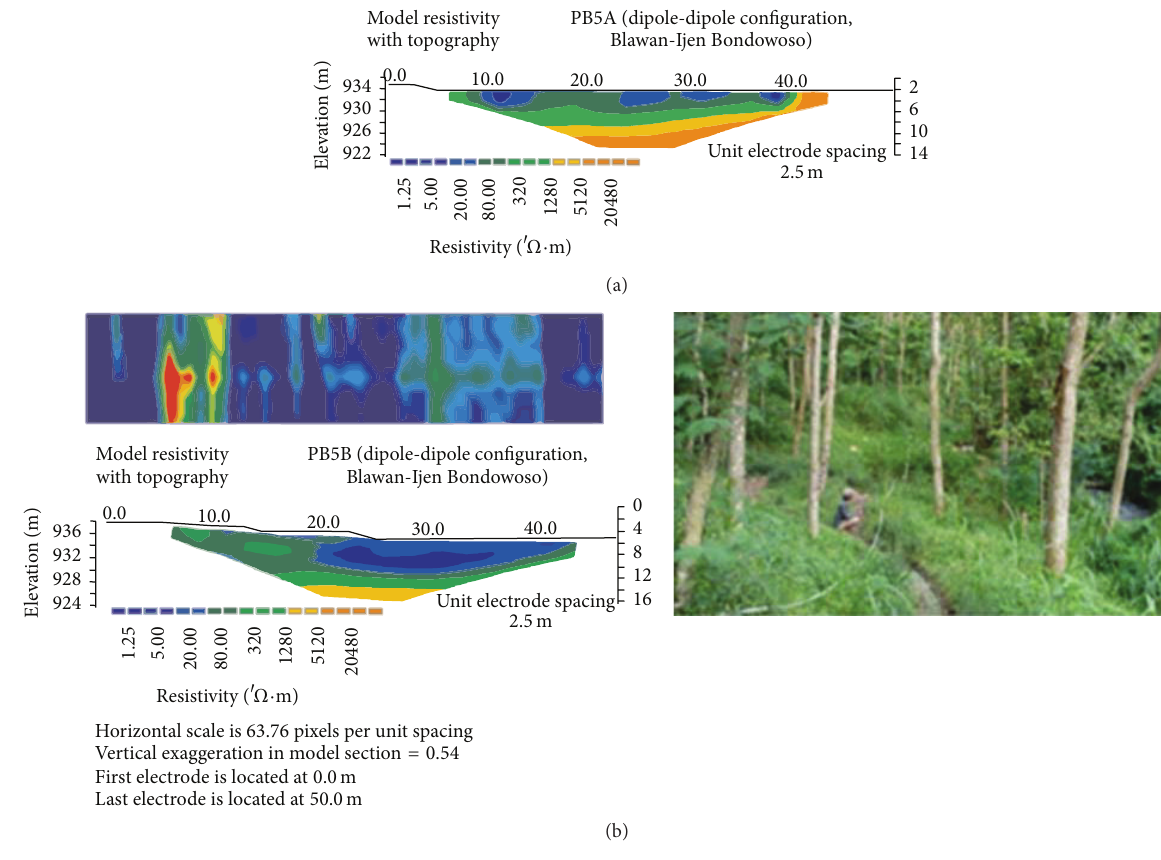
Figure 9: 2D Resistivity Mapping and GPR amplitude slice in locations (a) PB5A and (b) PB5B.